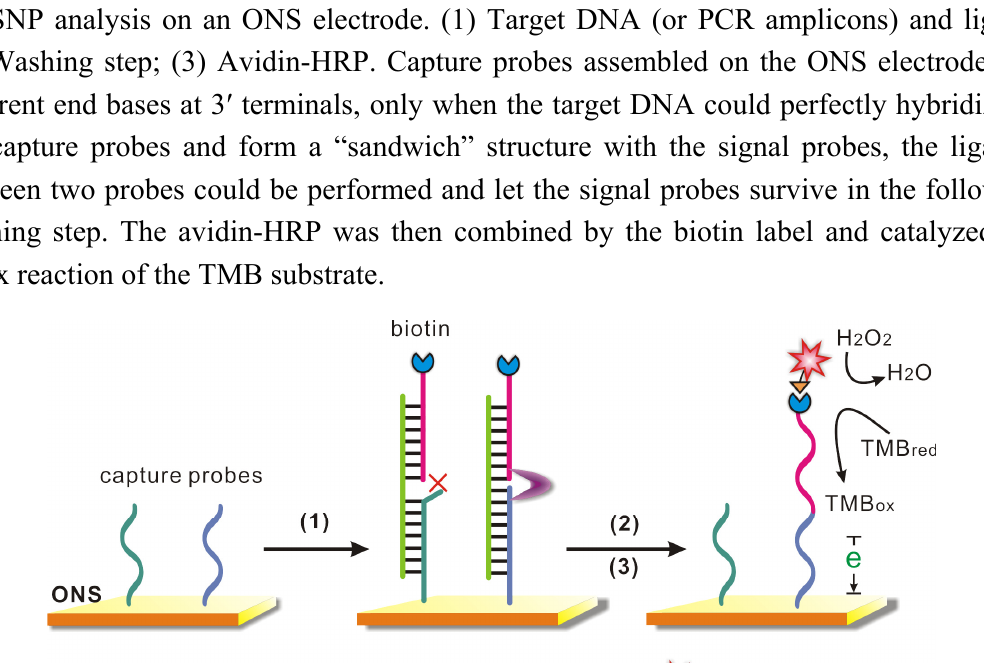
Scheme 1 . Schematic illustration of the ligation based electrochemical DNA biosensor for the SNP analysis on an ONS electrode. (1) Target DNA (or PCR amplicons) and